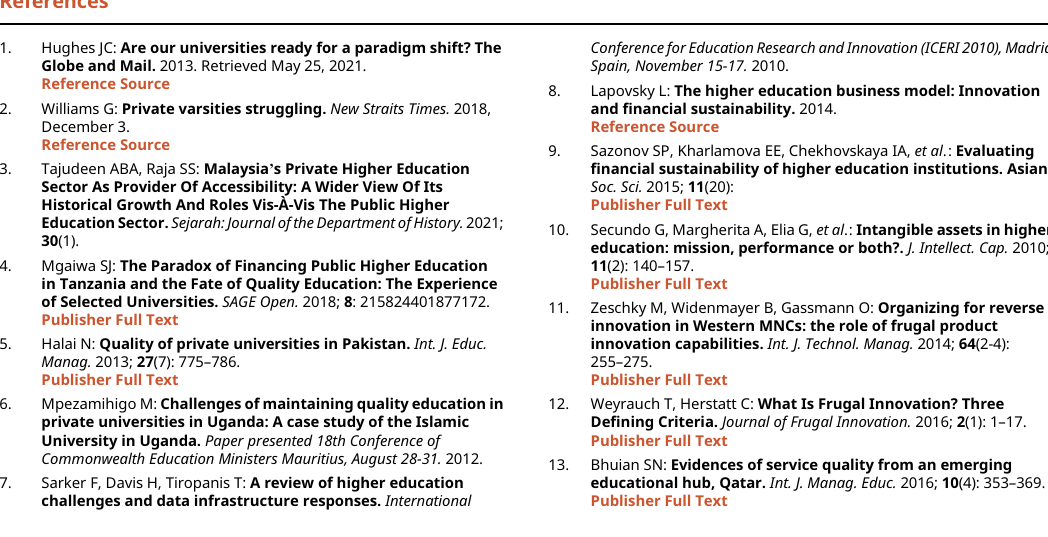
Figshare: Data file.xlsx, https://doi.org/10.6084/m9.figshare.14881437.v1. 97